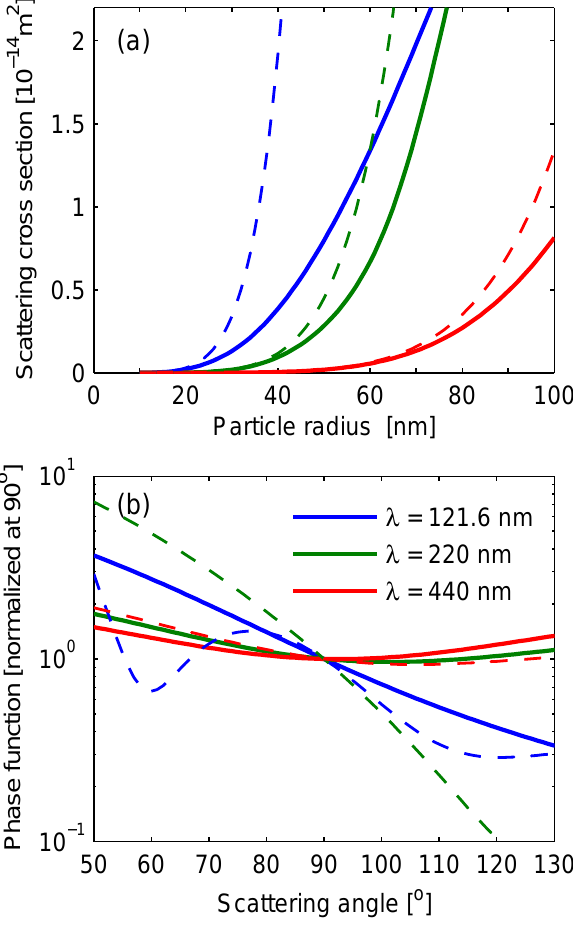
Fig. 3. (a) Mie scattering cross section for spherical ice particles at different wavelengths (solid lines) and comparison to the r 6 - dependence of pure Rayleigh scattering (dashed lines). (b) Phase functions at different wavelengths for particles of radii 30nm (solid lines) and 70nm (dashed lines). The colour code is the same for both panels with blue, green and red lines representing Lyman- α , 220nm and 440 nm, respectively.